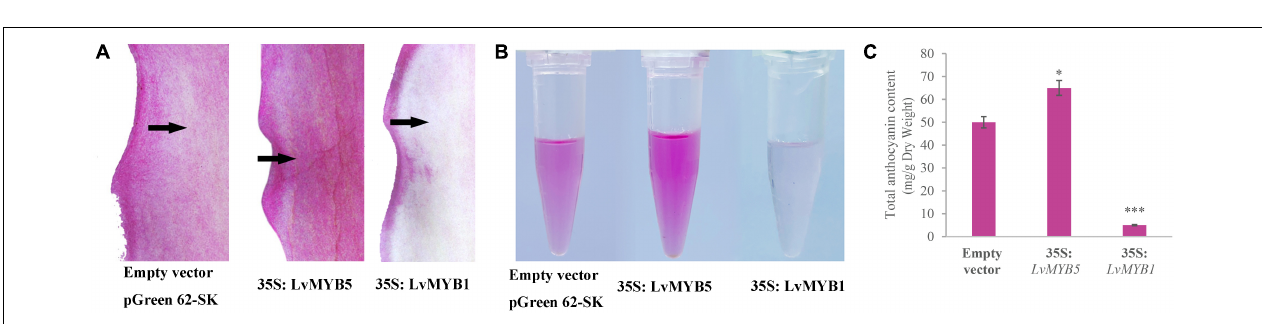
FIGURE 4 | Expression analysis of LvMYB1 and LvMYB5 in Nicotiana benthamiana leaves. (A) Transient overexpression of LvMYB1 and LvMYB5 in Nicotiana benthamiana leaves. (B) Extraction of total anthocyanins from the N. benthamiana leaves in (A) . (C) Total anthocyanin contents in Nicotiana benthamiana leaves agroinfiltrated with different gene constructs. Data are means ( ± SD) of three biological replicates per construct ( ∗∗∗ p ≤ 0.01). (D) Expression levels of structural genes and MYB gene in Nicotiana benthamiana leaves. Different letters indicate statistically significant differences between the samples.